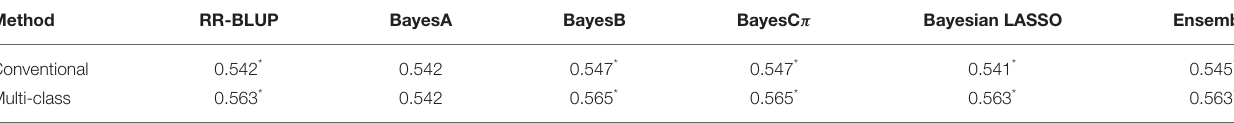
TABLE 1 | Mean prediction accuracy comparison between conventional and multi-class Bayesian Alphabet on single-trait simulated data. Method RR-BLUP BayesA BayesB BayesC π Bayesian LASSO Ensemble Conventional 0.542 * 0.542 0.547 * 0.547 * 0.541 * 0.545 * Multi-class 0.563 * 0.542